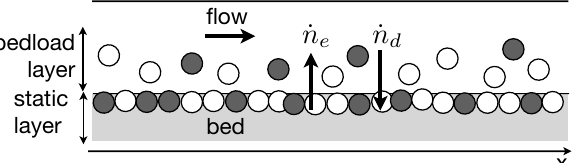
Fig. 1. A granular bed sheared by a steady and uniform flow. The sediment bed is a mixture of marked (in grey) and unmarked